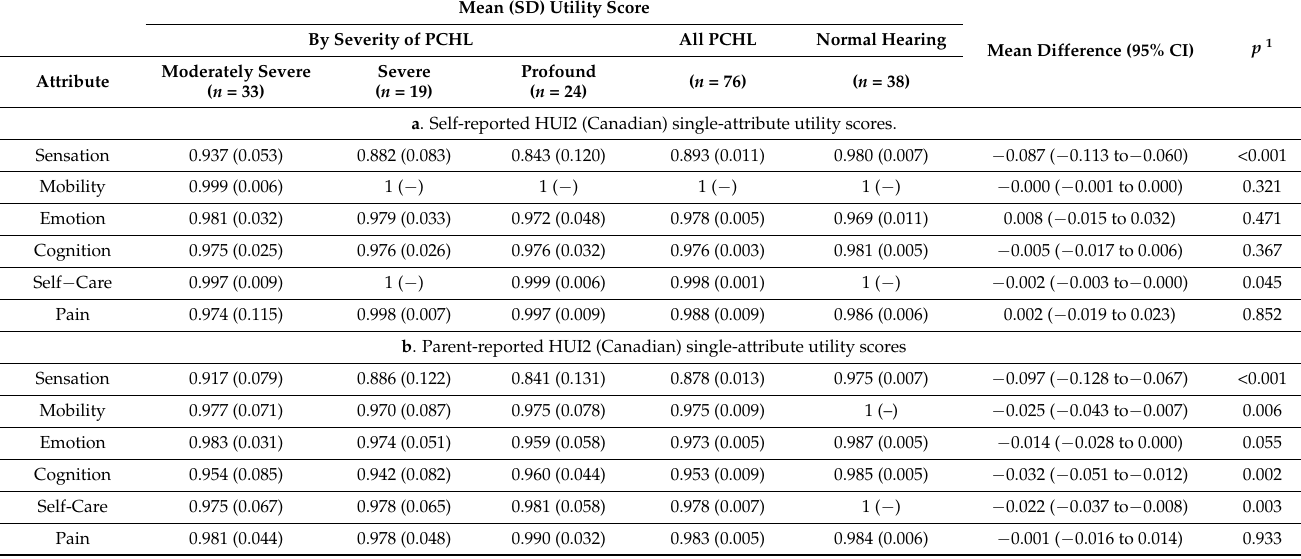
Table A2. Single attribute utility scores by respondent group, HUI measure (and country tariff